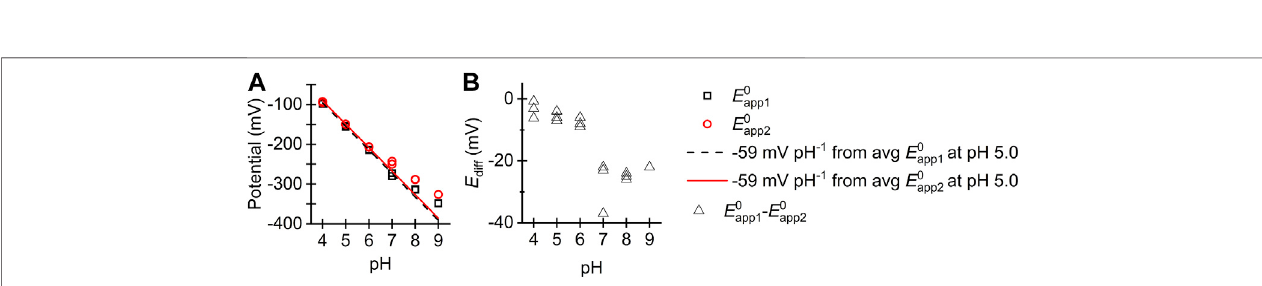
FIGURE5| Objectivefunctionsurfacefor (A) pH4.0experiment3and (B) pH9.0experiment3calculatedusingsimulateddatafromthe n 1 (cid:2) n 2 (cid:2) 1reactionmodel withallinputparameterssettothebest fi tvaluesfrom Table1 and SupplementaryTableS4 except k 0 app1 and k 0 app2 whicharevariedbetween0 s − 1 and4,000 s − 1 and sampled every 20 s − 1 .